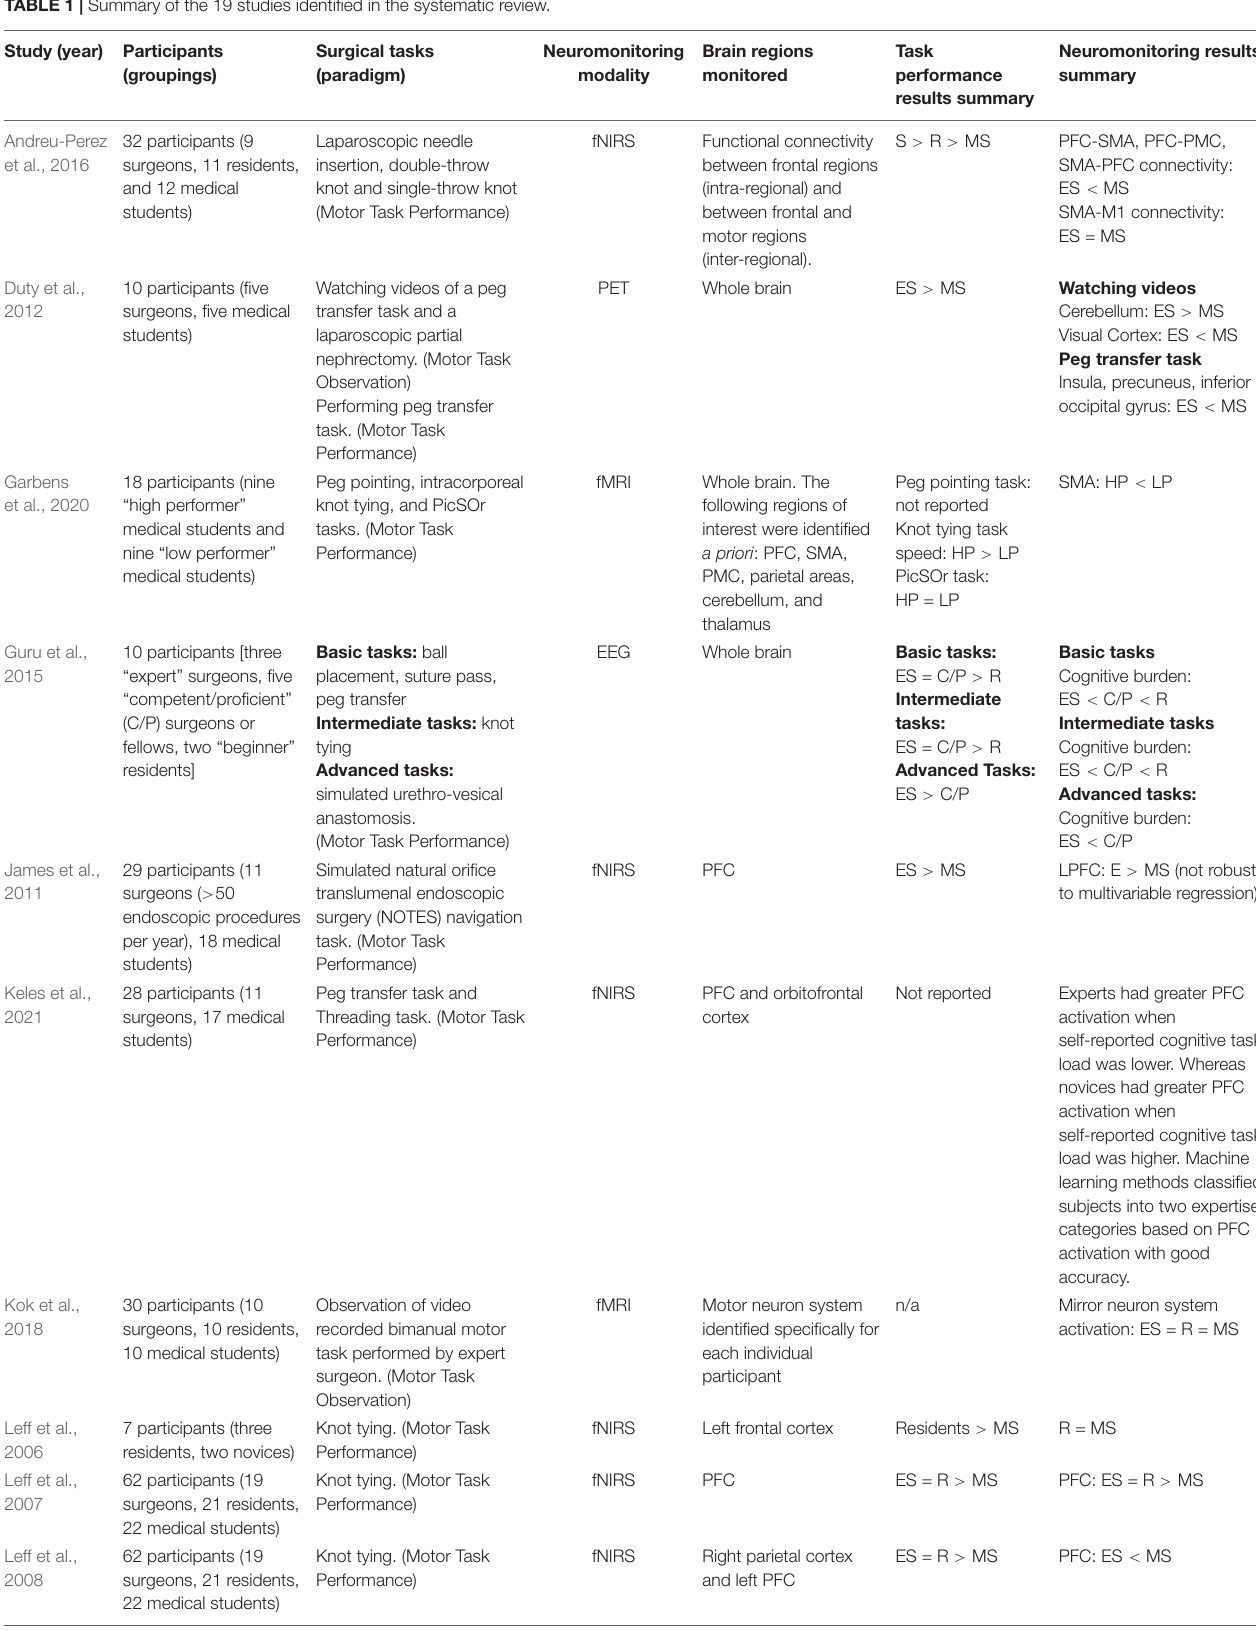
TABLE 1 | Summary of the 19 studies identified in the systematic review. Study (year) Participants